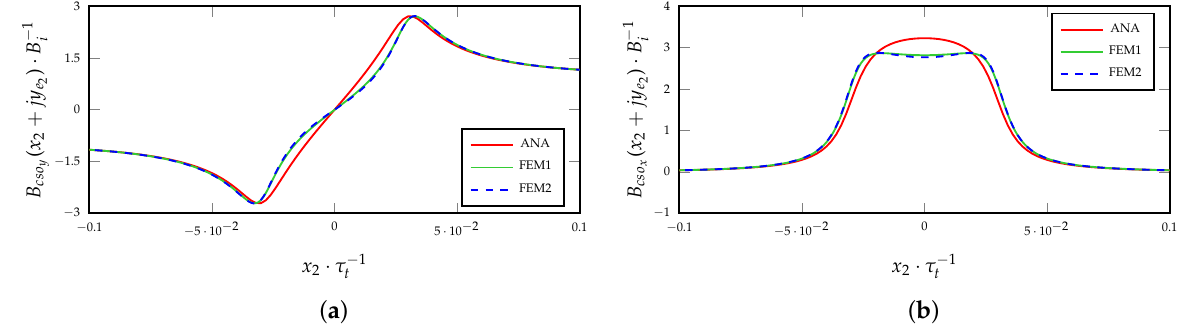
Figure 10. p.u. flux density distributions on the exploration line γ e components for the case of studies: 1. Figure 9a (FEM1), 2. Figure 9b (FEM2) and 3. Figure 9c (analytical using (4)), ( − τ t / 10 ≤ x 2 ≤ τ t / 10). Here, the same procedure will be applied to the armature reaction to see the outcomes. Starting from the slotless current sheet model stated in (4) it can be written [14]: